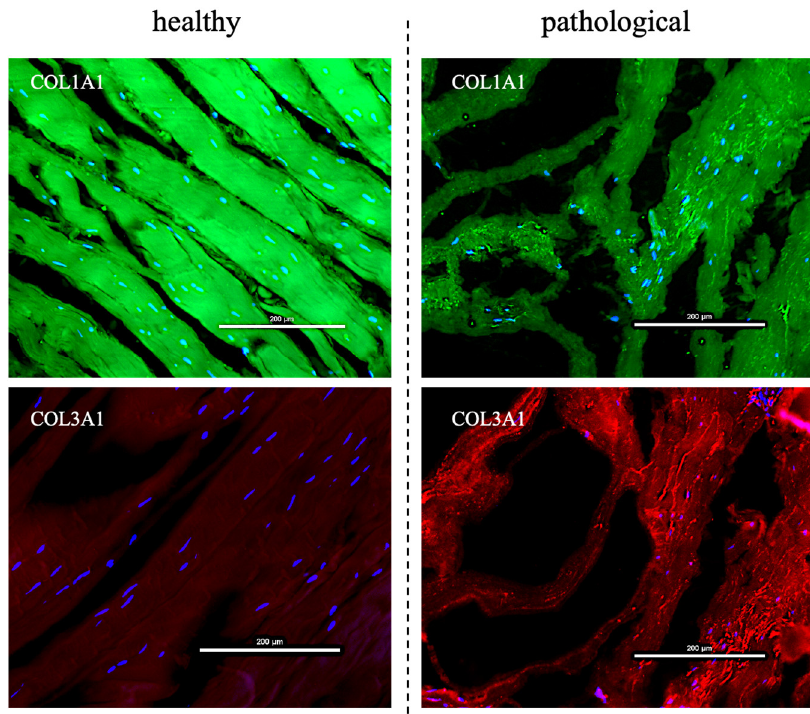
Figure 4. Immunofluorescence images of type I (green) and type III (red) collagen expression in healthy and pathological tendon samples. Images show that the healthy tendon has well shaped and organized fibers with a prevalence of type I collagen, whereas the pathological tissue has less orga- nized, randomly oriented fibers and with a heavy presence of type III collagen. Scale bar: 200 μm.